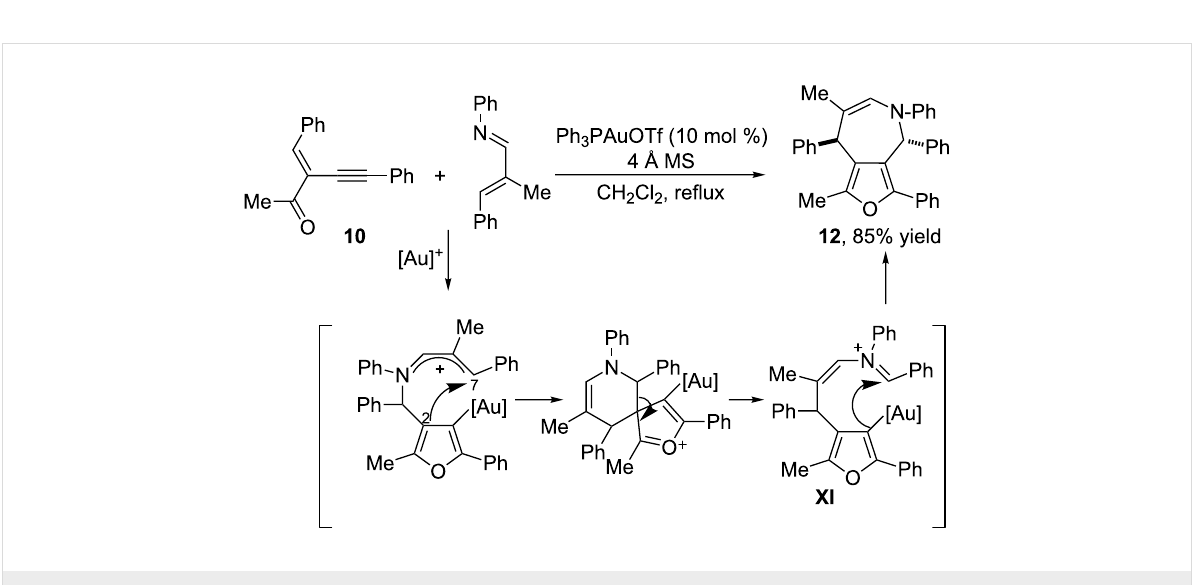
Scheme 7: Gold-catalyzed 1,3-dipolar cycloaddition of 2-(1-alkynyl)-2-alken-1-ones with α , β -unsaturated imines